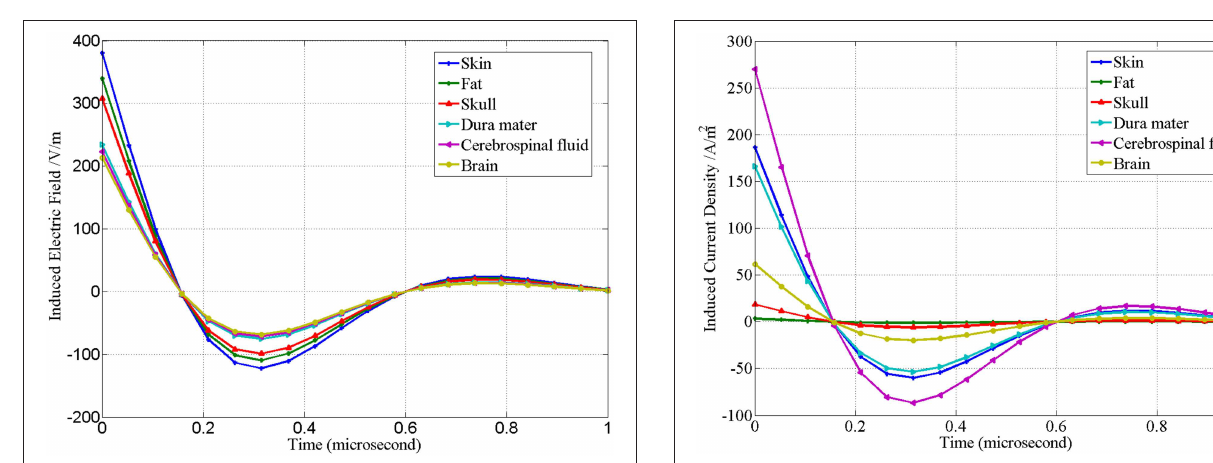
FIGURE 7 | Waveform of the intensity of induced electric field of the upper surface of brain tissues at the central projection of “figure-of-eight coil” changing with time.